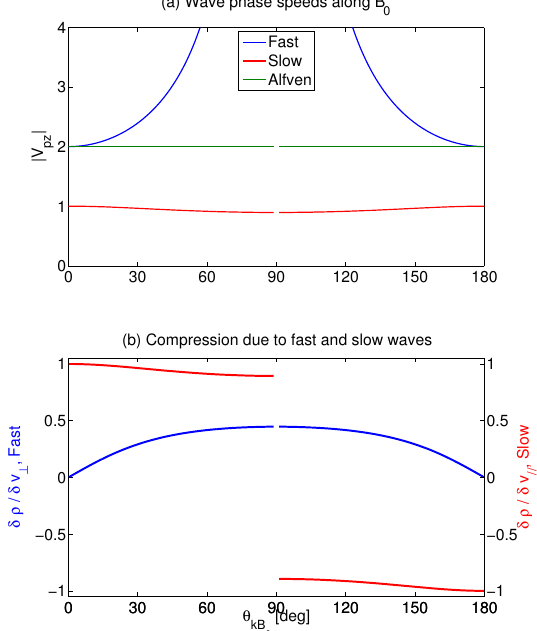
(cid:12) (cid:12) (cid:12) V p z (cid:12) versus angle